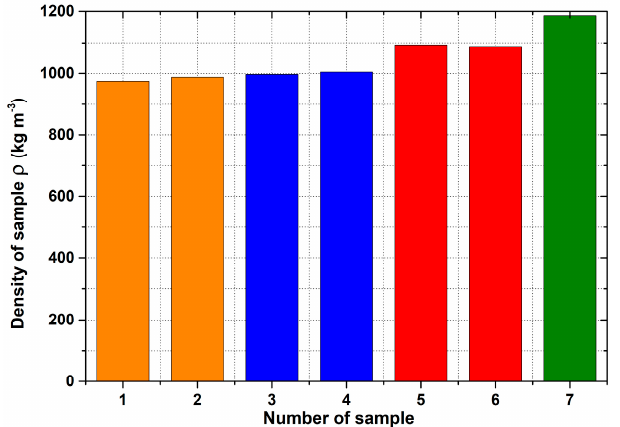
Figure 7. Density values of individual aluminum porous samples. Orange colour: 1—SAM1; 2— SAM2. Blue colour: 3—SAM3; 4—SAM4. Red colour: 5—SAM5; 6—SAM6. Green colour: 7— SAM7.